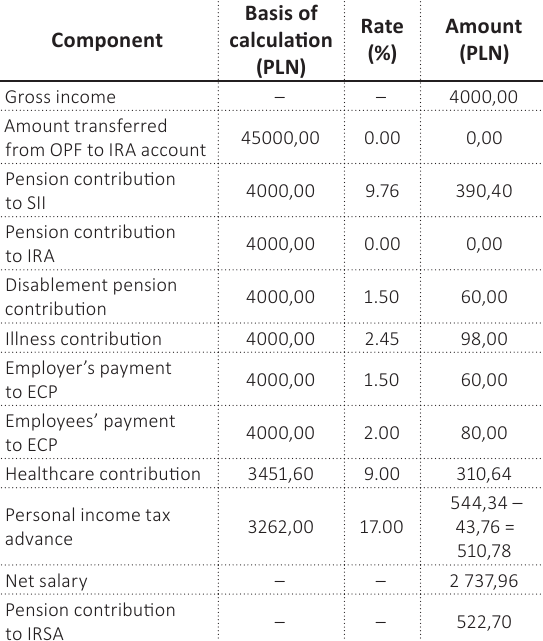
Table 7. Variant 2 – participation in ECP and membership in IRA